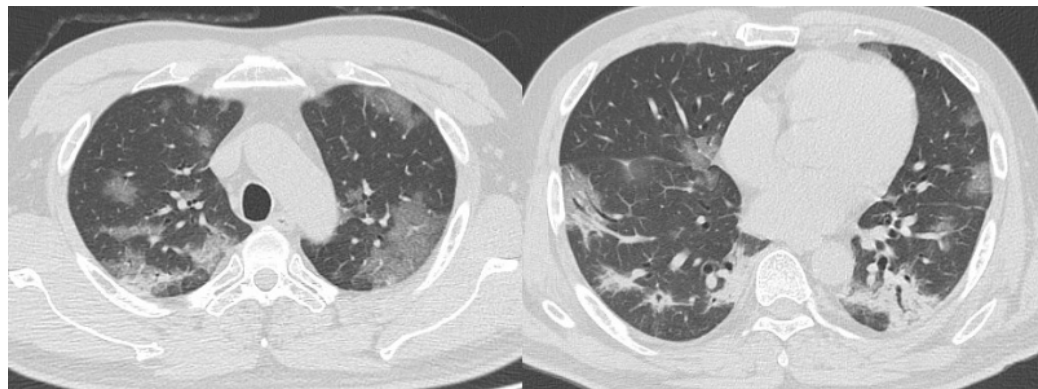
Figure 2. Percentage and number of COVID19 patients per CO-RADS category. The histogram shows the proportion of COVID19 patients per CO-RADS category. The higher the CO-RADS category, the higher the proportion of COVID-19 positive patients.